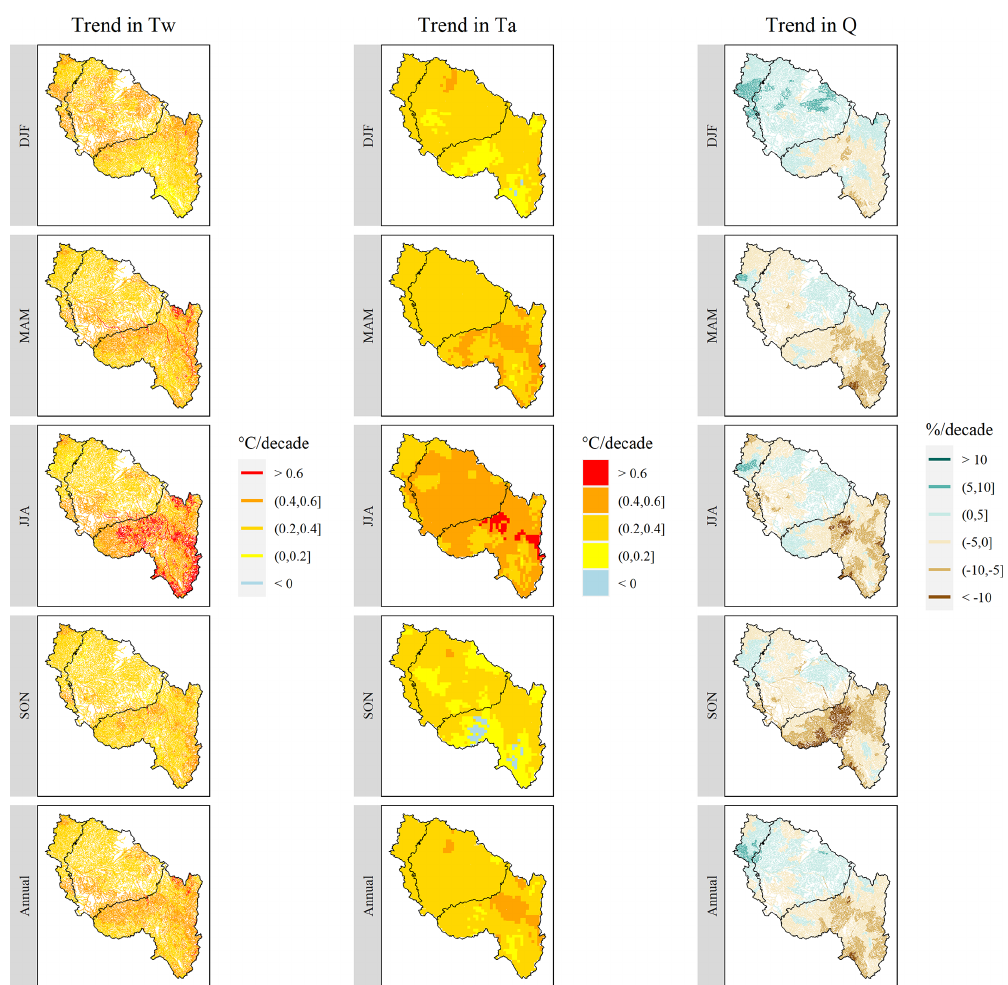
Figure 3. Spatial variability of trends in seasonal and annual T w , T a , and Q over the 1963–2019 period based on Sen’s slope estimator. Solid black lines show the Hydro-Ecoregion (HER) delineation (see Fig. 1). The statistical significance of these trends is given in Fig.